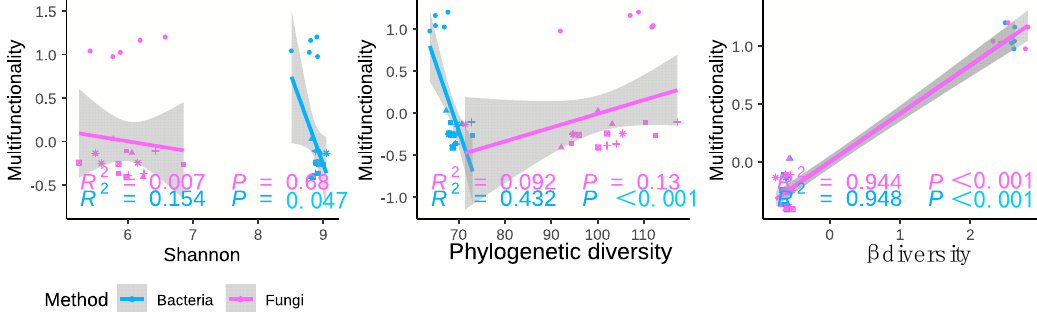
Figure 4. The relationships between soil EMF and Shannon indexes, phylogenetic diversities, and communities compositions ( β diversity) of bacteria and fungi.